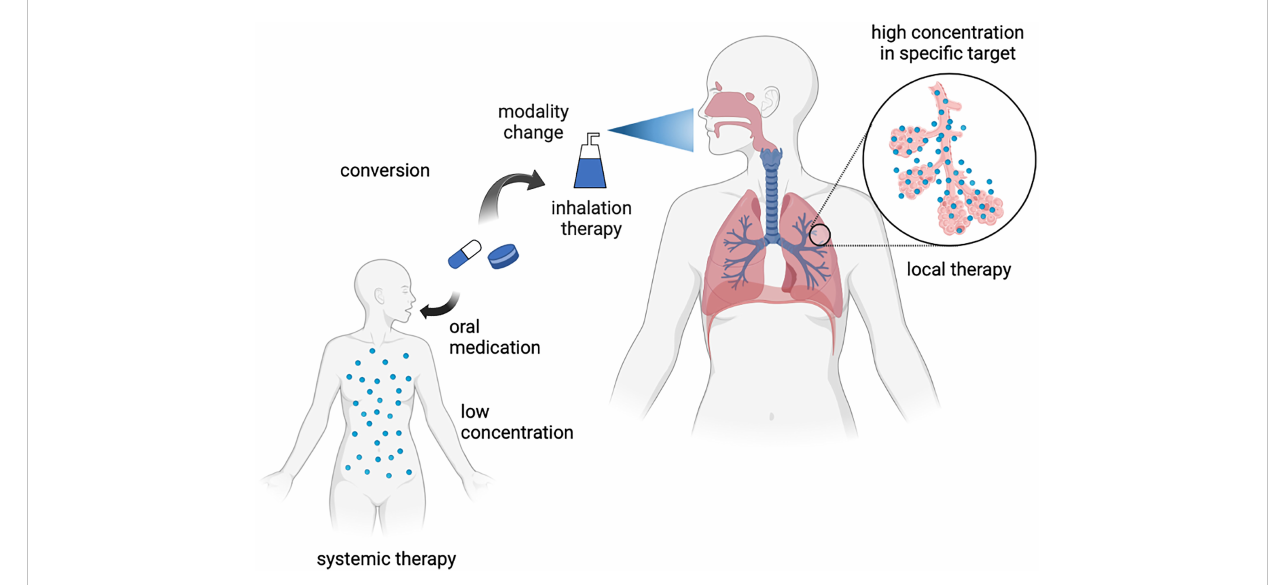
FIGURE 1 Concept of inhalation therapy with drugs against metabolic diseases for respiratory diseases as drug repositioning. Created with